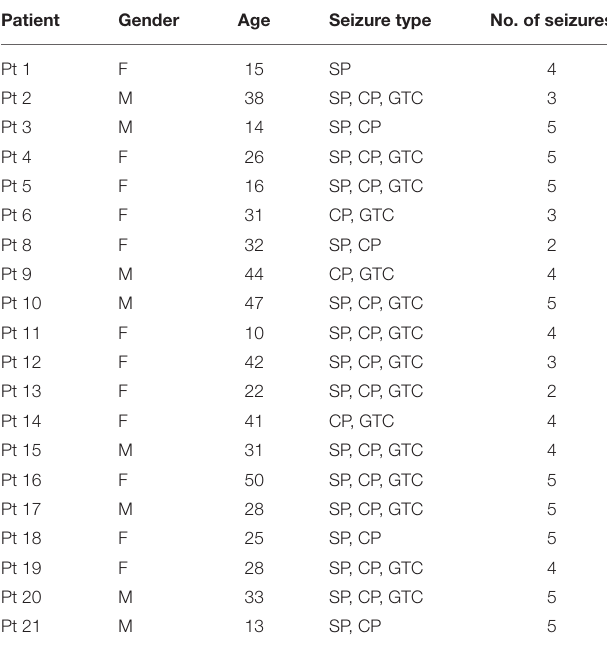
TABLE 1 | Details of the Freiburg Hospital test set.